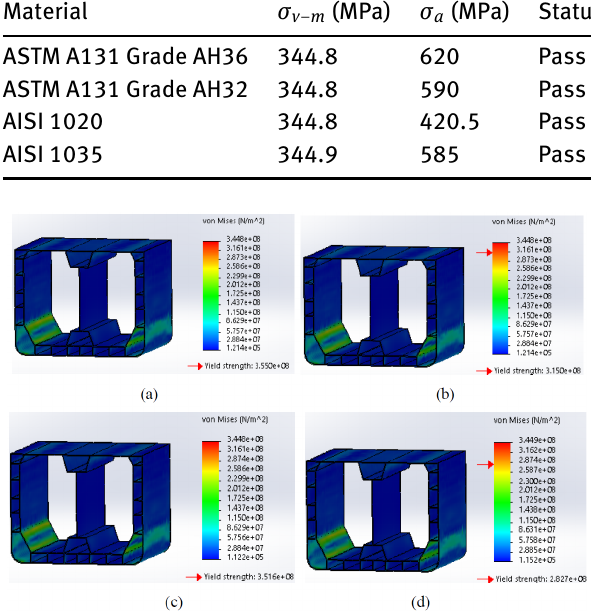
Figure 9: Stress contour plots at (a) Grade AH36, (b) Grade AH32, (c) AISI 1020, and (d) AISI 1035.